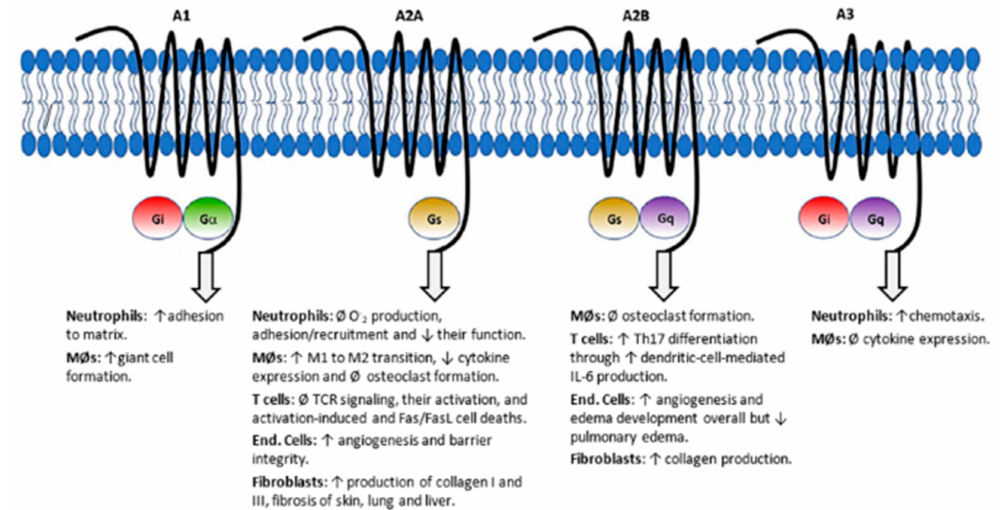
Figure 8. Adenosine receptors and signaling pathways towards anti-inflammatory phenotype macrophage polarization. Abbs.: ↑ = increase, ↓ = decrease, Ø = inhibition, End. = endothelial,